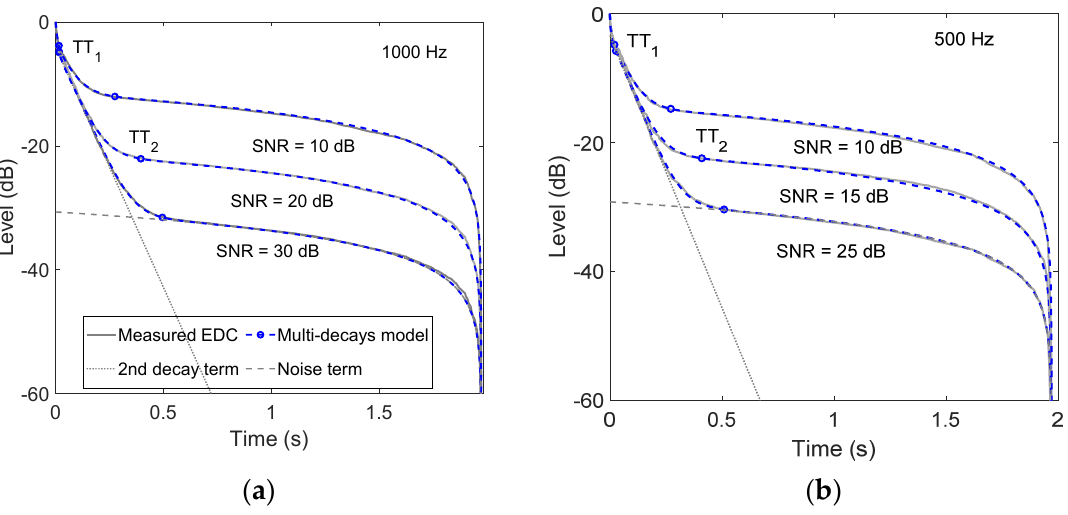
Figure 5. Comparison of the normalized EDCs generated from the proposed procedure with the non-exponential decay model (Equation (7)) and the measured RIR with added pink noise ( − 60 dB to − 40 dB) and filtered in the octave band at the 1 kHz ( a ) and 500 Hz ( b ) octave bands. Because the DT estimated from the ER depends on the LIR 2 and the LN , the correct DTs and the small values of the ∆ E1 and the ∆ E2 proved that the proposed procedure yields accurate model parameters. Compared to the results presented in Figure 6a,b,